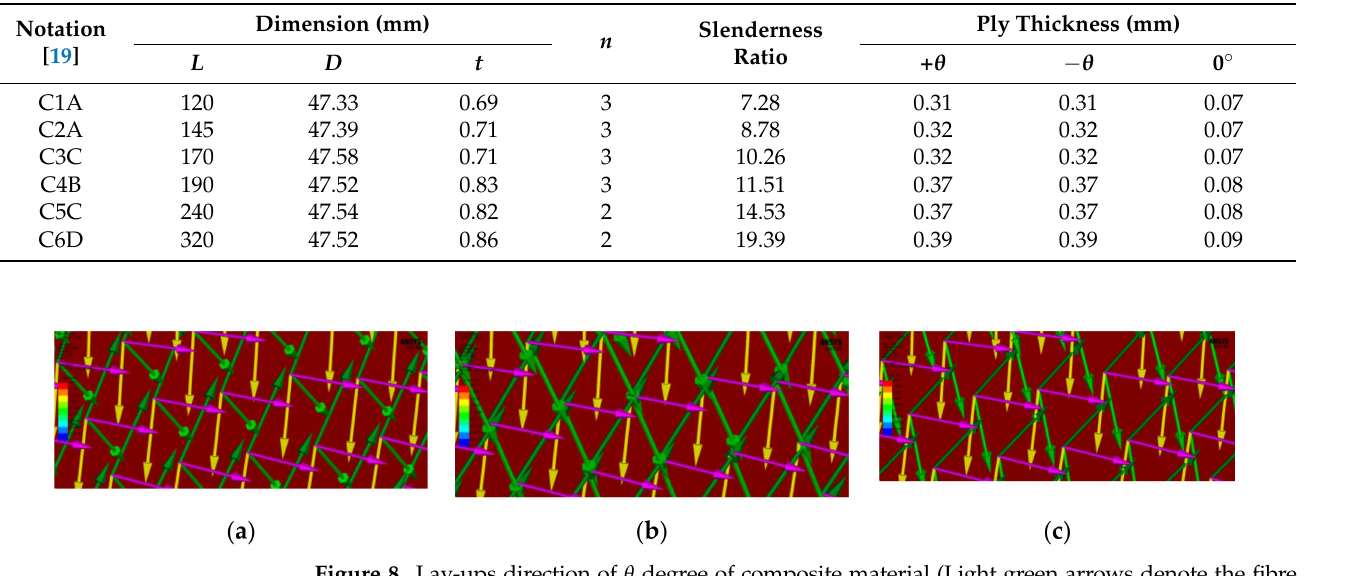
Table 7. Geometrical information for application models.